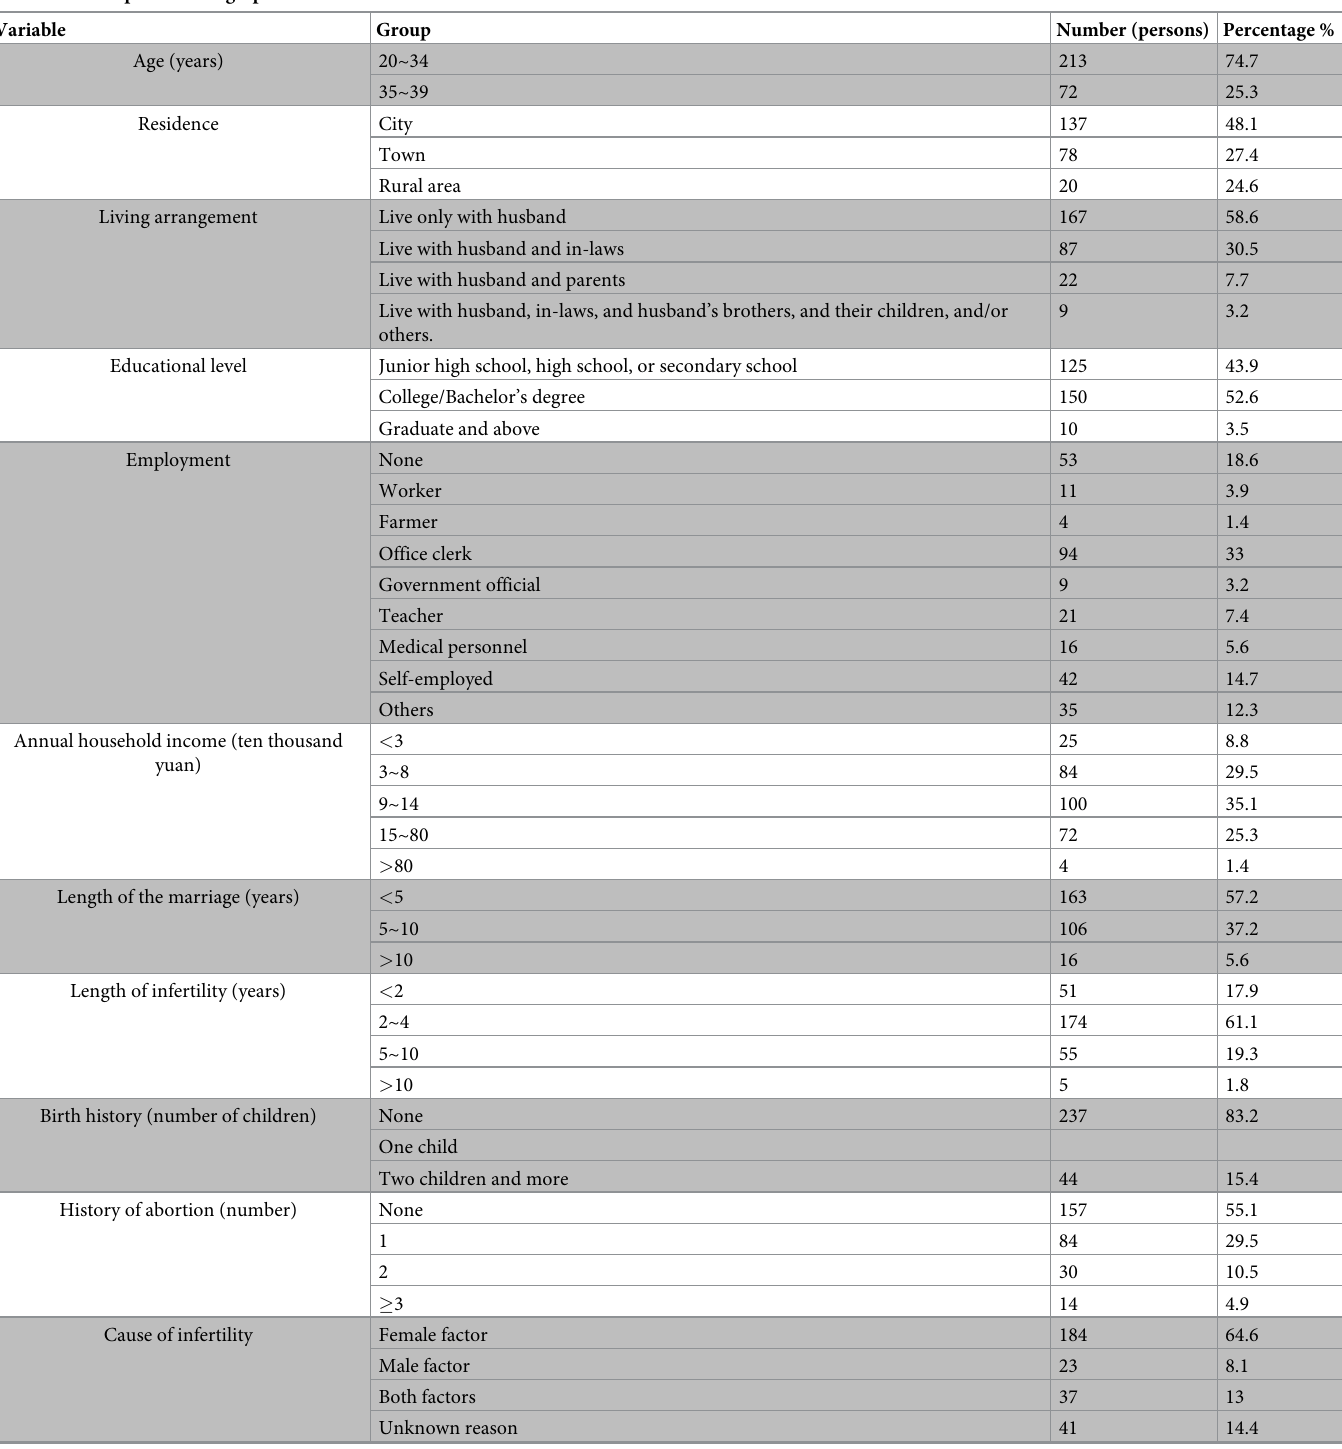
Table 1. Participants’ demographic and clinical